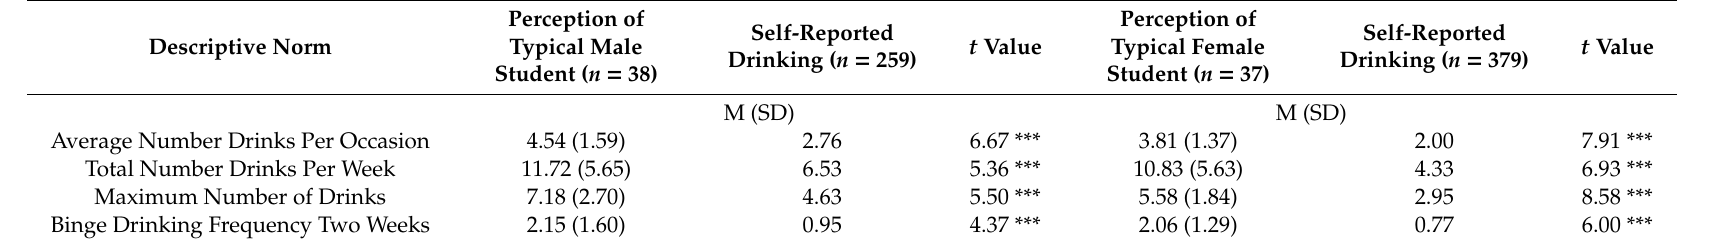
Table 5. Students’ perceptions of typical same-sex USC student compared to students’ actual